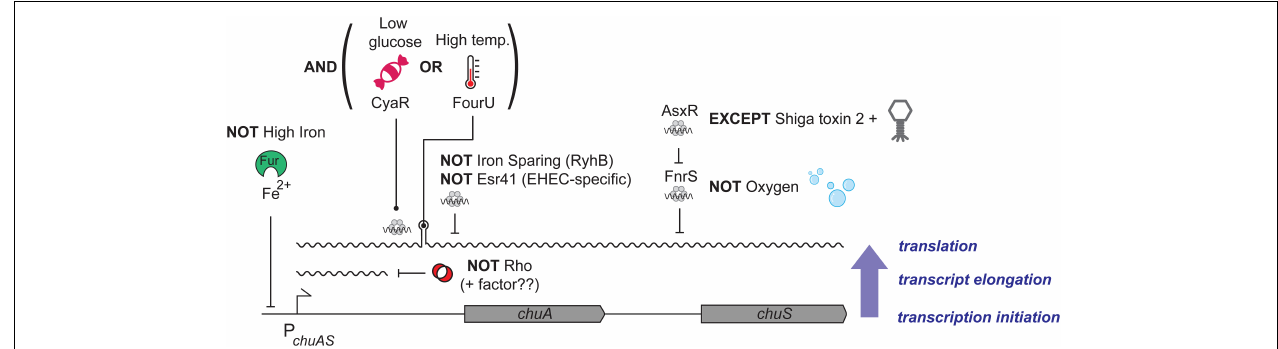
FIGURE 7 | Model of chuAS regulation. Regulation of chuAS expression occurs at the transcriptional, transcript elongation, and translational levels (indicated blue, right). The dependence of each layer on the previous creates regulatory AND gates. ( Bottom layer ) Repression of chuAS transcription by Fe-loaded Fur is relieved under iron-limited conditions allowing transcription initiation. ( Middle layer ) Elongating RNAP is prematurely terminated by Rho within the 5 (cid:48) UTR of chuA . An additional factor (potentially another sRNA) is likely to modulate Rho termination and allow read-through transcription. ( Top layer ) Translation of the chuAS transcript is activated by the cAMP-responsive sRNA CyaR or temperatures ł37 ◦ C that melt the FourU thermometer. Melting of the chuAS mRNA FourU element can be overridden under iron-sparing conditions by the sRNA RyhB or the EHEC-specific sRNA Esr41 that repress translation from the exposed RBS. The downstream haem oxygenase encoded by chuS is repressed under aerobic conditions by the sRNA FnrS, except in EHEC where repression is relieved by the sRNA sponge AsxR carried by the Shiga toxin 2-encoding